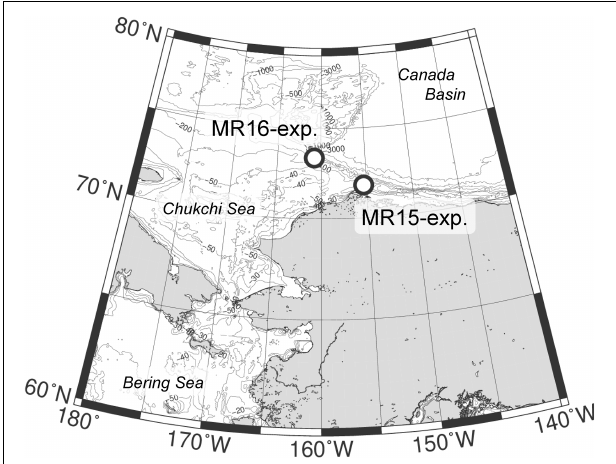
FIGURE 1 | Sampling locations in the western Arctic Ocean with names of the incubation